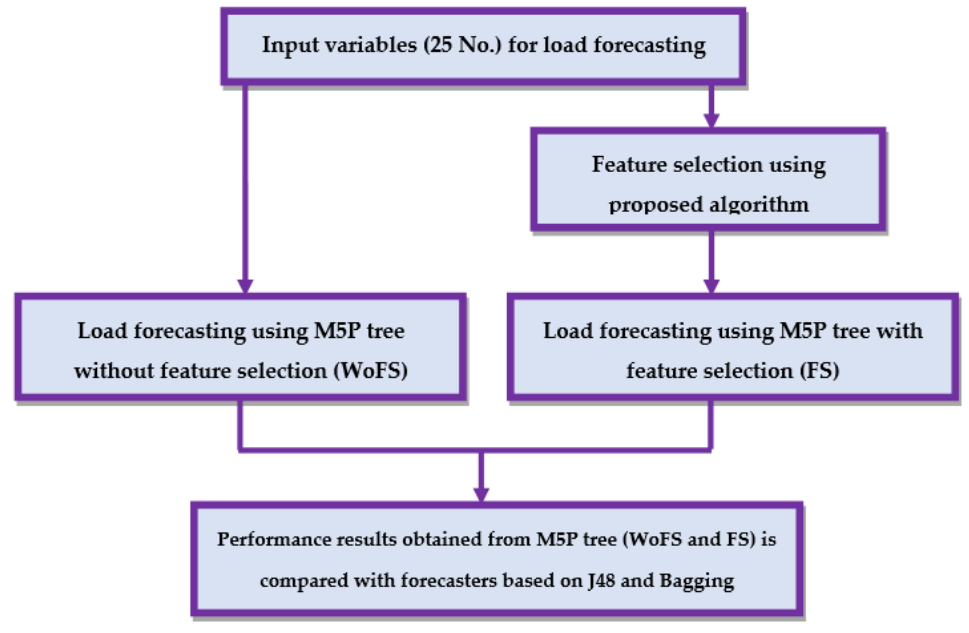
Figure 1. Methodology adopted for comparison of forecasts with FS and